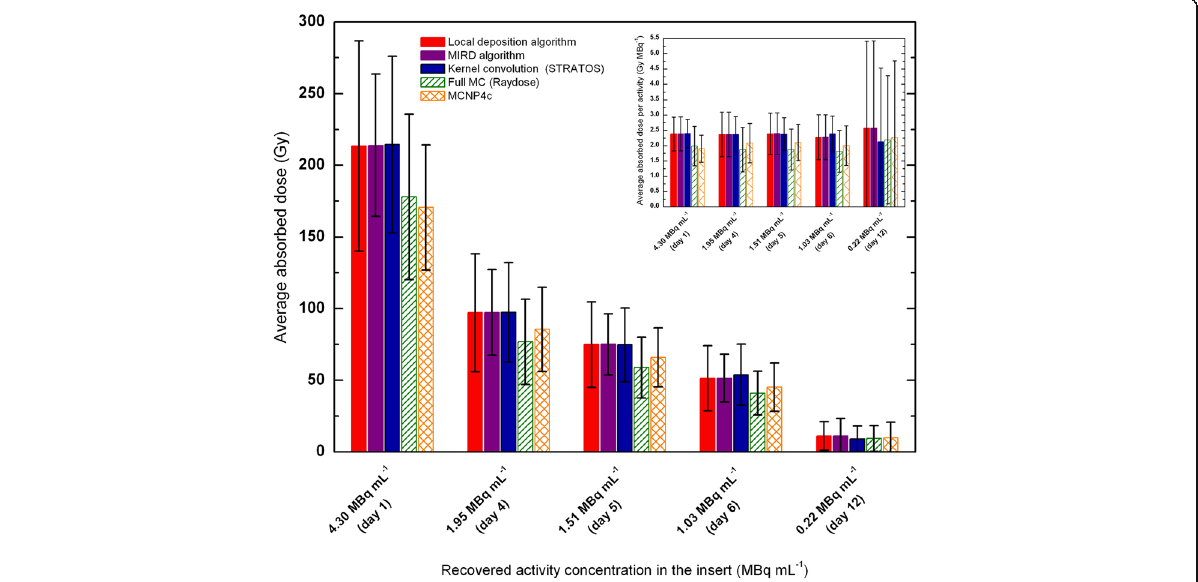
Fig. 5 Comparison of absorbed doses. Different dose calculation algorithms were used to compare average absorbed doses, namely (I) LD algorithm (red), (II) MIRD analytical approach (violet), (II) Kernel convolution using Philips Stratos (blue), (IV) full MC using Raydose (green stripe pattern), (V) MCNP4c (orange crosshatch pattern). The vertical bar chart displays the mean absorbed dose and its standard deviation. For methods I-II-II, the standard deviation was assessed from dose-volume-histograms obtained after calculation. For methods IV and V, the activity of 90 Y contained in the cylindrical insert was recovered from 90 Y – PET images using the dAVH approach described by Eq. 1. Then, the mean activity value, along with its standard deviation, has been used to assess doses with methods IV and V, thus providing a mean dose ± standard deviation. MC-based dose evaluations are reported with a different pattern to differentiate MC calculations with other algorithms that do not directly account for the presence of the acrylic wall. Average absorbed doses are reported along with their standard deviations. All dose algorithms provided comparable dose estimates with deviations below 9%, except for dose calculations performed on day 1, where the standard deviation over the average absorbed dose values is 20%. Insert: comparison between average absorbed dose per unit activity into the cylindrical insert. When the activity concentration decreases down to 0.22 MBq/mL (day 12) the standard deviation is approximately 100% the dose